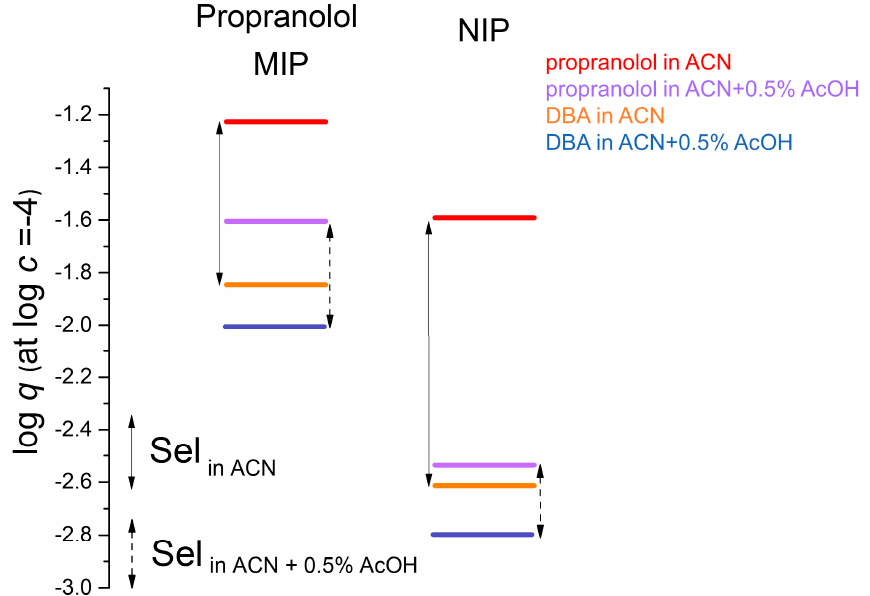
Figure 4. Propranolol and DBA adsorption on propranolol MIP and NIP, respectively, in acetonitrile (ACN) and in ACN + 0.5% acetic acid (AcOH).